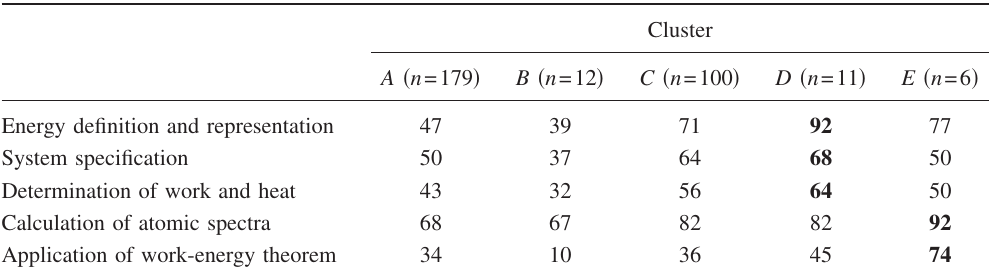
TABLE V. Five clusters and their scores (cid:1) percentages (cid:2) on different topics covered in the MIET. (cid:1) Bold prints indicate the highest scores among the five clusters. (cid:2) Cluster A (cid:1) n =179 (cid:2) B (cid:1) n =12 (cid:2) C (cid:1) n =100 (cid:2) D (cid:1) n =11